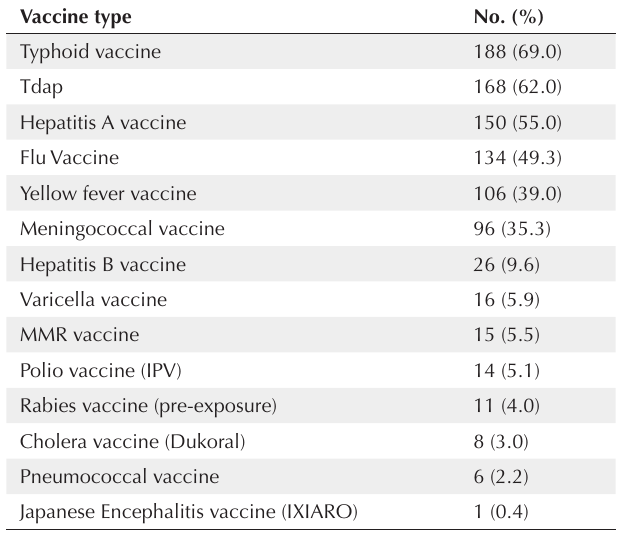
Table 6. Prescribed Vaccines Vaccine type Typhoid